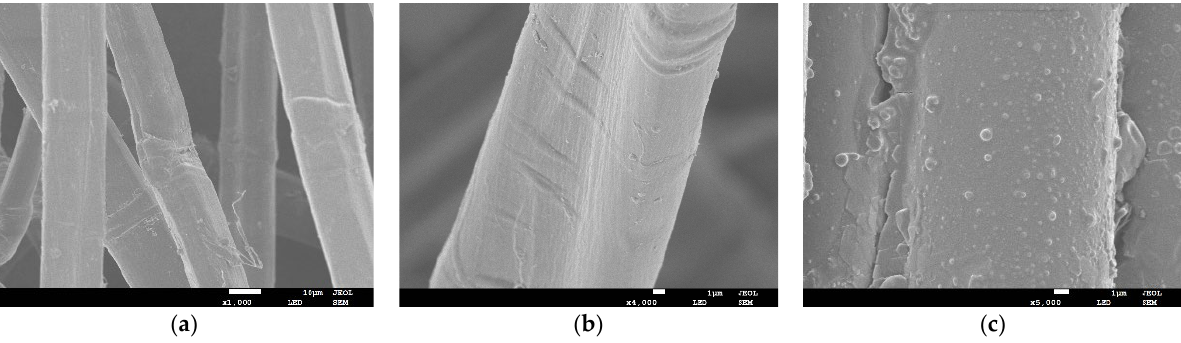
Figure 6. Scanning electron microscope photos of the longitudinal morphological structure of waste hemp fiber: ( a ) longitudinal irregular shape of the waste hemp fiber (×200); ( b ) rough structure of the surface of the waste hemp fiber (×900); ( c ) particle structure of the surface of the waste hemp fiber (×4000). Figure 6a indicates that the longitudinal thickness of waste hemp fiber is not uniform, with one portion having a round tube shape and the other part a flat band shape. Figure